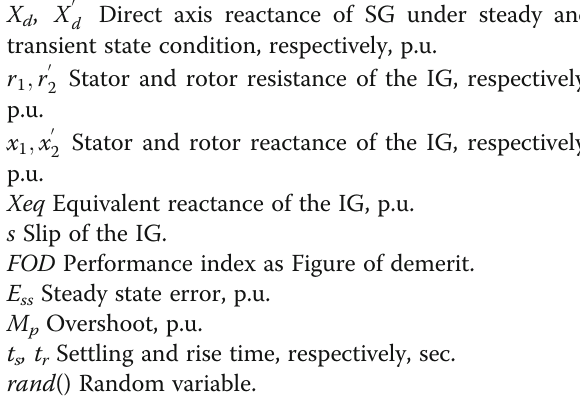
FOD Performance index as Figure of demerit.